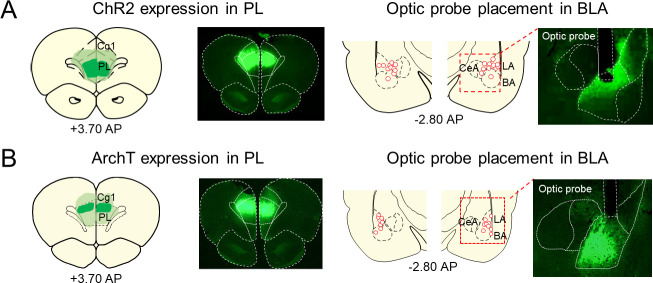
Spread of AAV expression and location of optic probes.(A) Min/max spread of AAV expression with example micrograph. (B) Location of optic fiber tips with example micrograph for each projection tested.